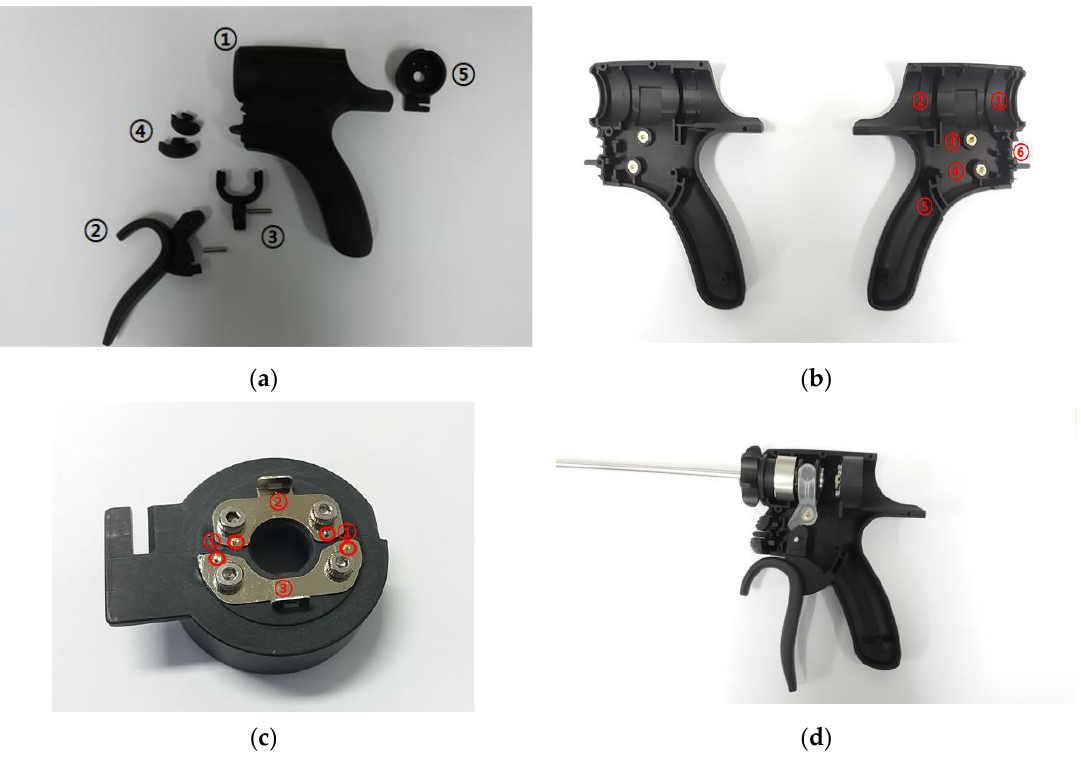
Figure 5. ( a ) Separate parts of the handheld instrument in its case. ( b ) Handle of the handheld instrument. ( c ) Terminal section. ( d ) Assembled handheld instrument in its case.